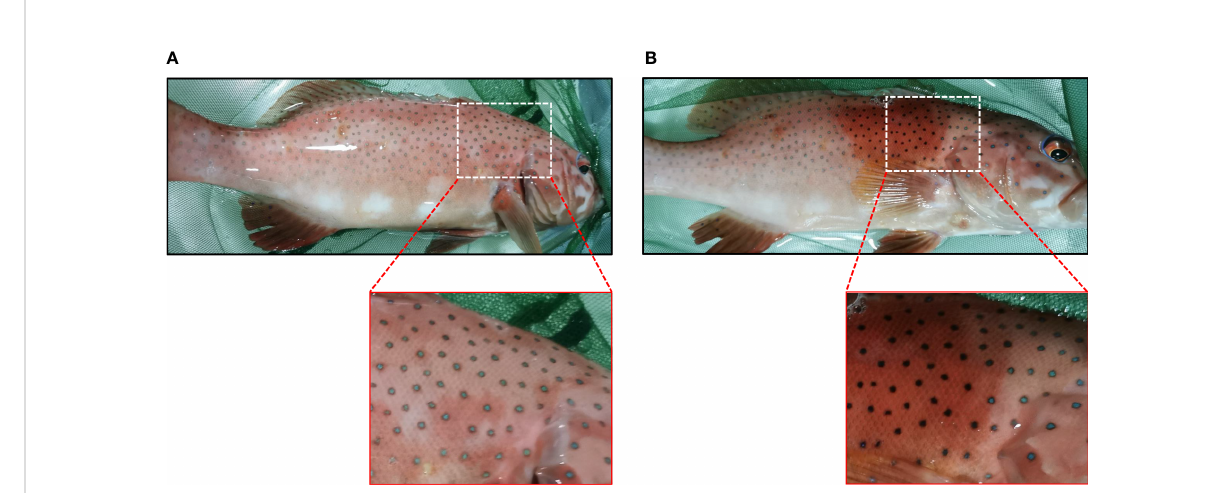
FIGURE 5 Photographs (taken with a camera) showing the color change of spots. (A) Upper panel, blue spots before forskolin treatment. Lower right, the enlargement of the boxed area in the above image. (B) Upper panel, 5 min after the treatment of 100 m M forskolin. Lower right, the enlargement of the boxed area in the above